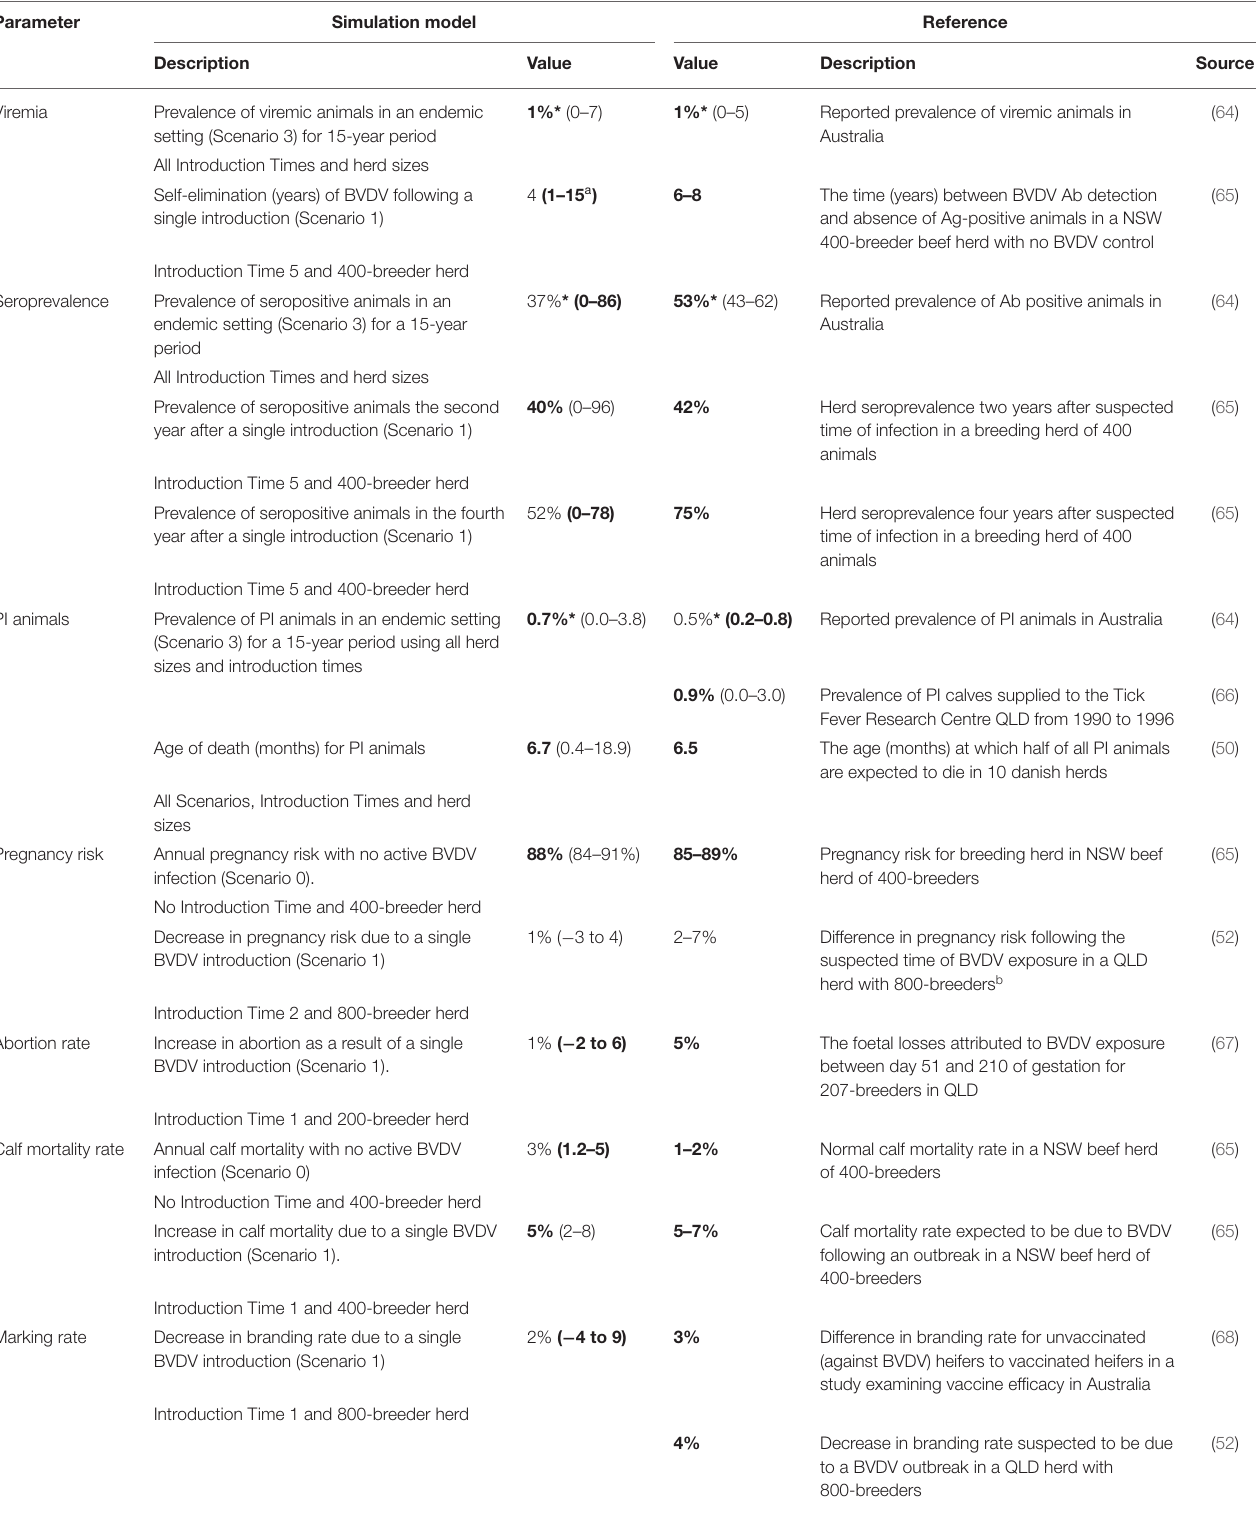
TABLE 5 | Comparison of model outputs to corresponding values from the published literature for external validation of a within-herd BVDV simulation model. All model outputs are presented as median (95% range) unless otherwise indicated.